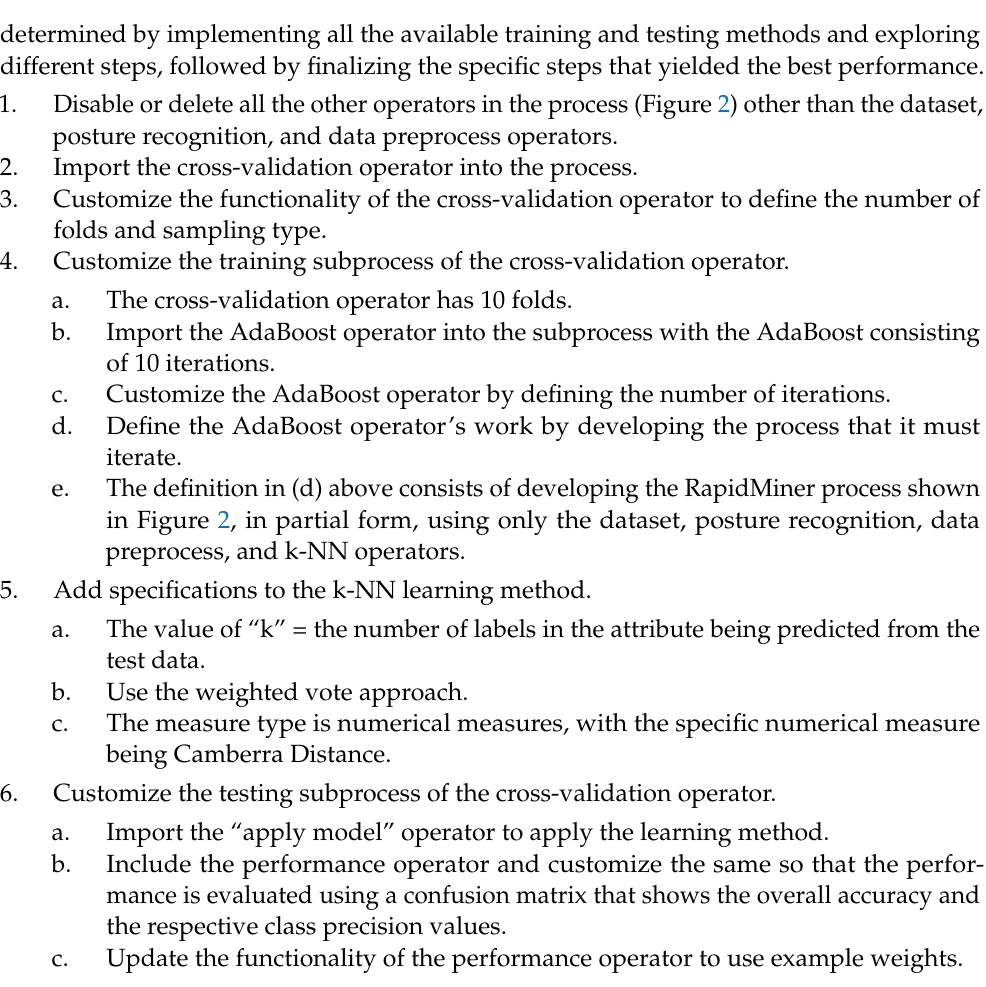
Figure 6. ( a ) The training and testing modules of the cross-validation operator from the process shown in Figure 5. ( b ) The iterative subprocess that was developed by customizing the AdaBoost operator is shown in Figure 6a. The performance characteristics of this approach were studied and analyzed using a confusion matrix to determine the overall performance accuracy and the subclass preci- sion values for detection of falls and fall-related motions—falling, lying, being on all fours, and standing up from lying for the first dataset [50]. The confusion matrix that outlined the performance accuracy of our approach when tested on the first dataset [50] is pre- sented in tabular form in Figure 7.